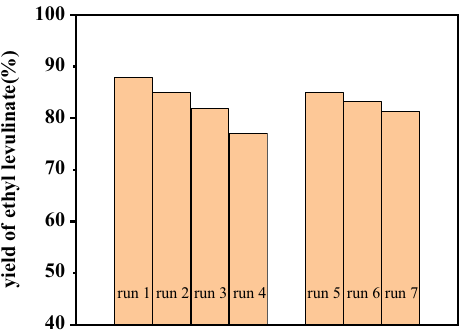
Figure 6: E ff ect of recycled TUD - 1 on yield of EL. Reaction condition: the fi rst four runs washed by ethanol, and the latter three calcined at 600°C for 6 h.